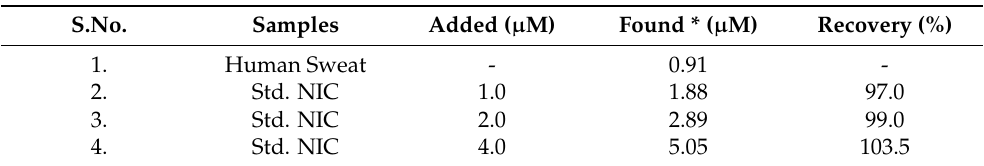
Figure 16. Amperogram was recorded to calculate the recovery percentage by using MX- ene/PHC/GCE in sweat sample and various concentrations of standard nicotine (NIC) solutions added in to 0.1 M phosphate buffer. PBS was stirred with rotation rate of 750 rpm at RT. Table 2. Determination of NIC concentration in human sweat sample using MXene/PHC/ GCE